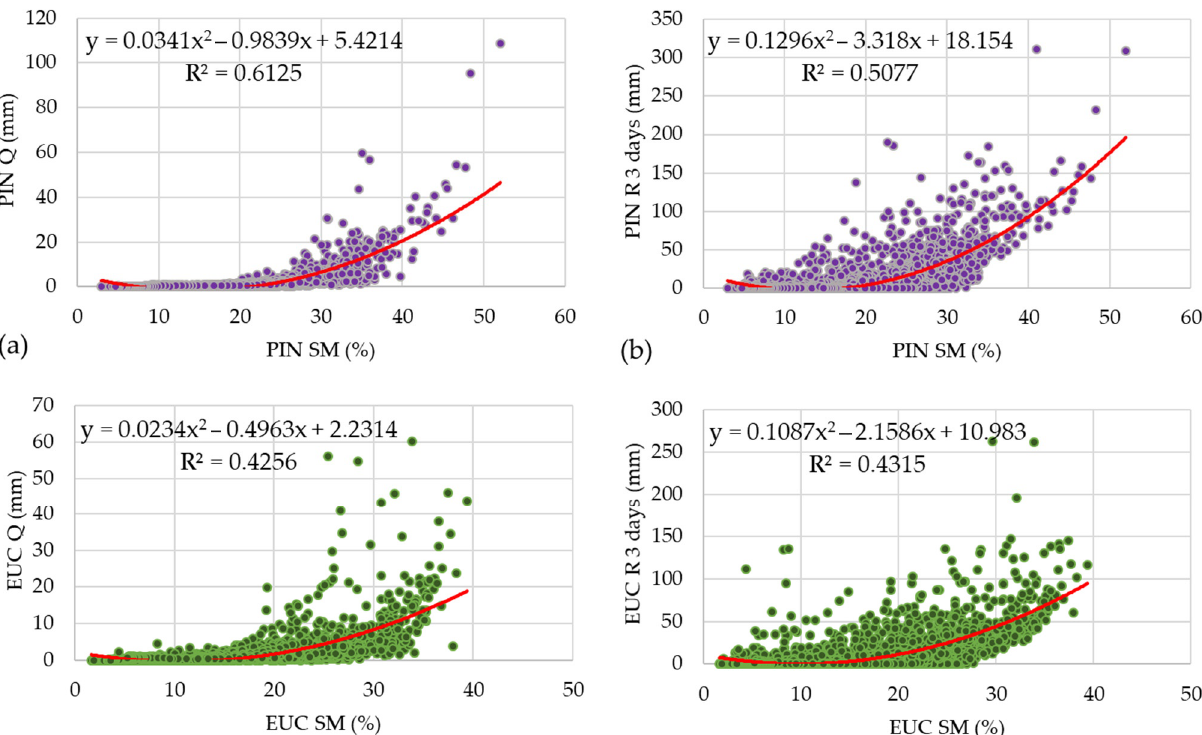
Figure 5. Polynomial relation and equation curve for PIN (top) and EUC (bottom) over the six hydrological years for average daily soil moisture content and ( a ) streamflow; and ( b ) rainfall over the 3 antecedent days. SM, soil moisture content; Q, streamflow; R-3days, precipitation in previous 3